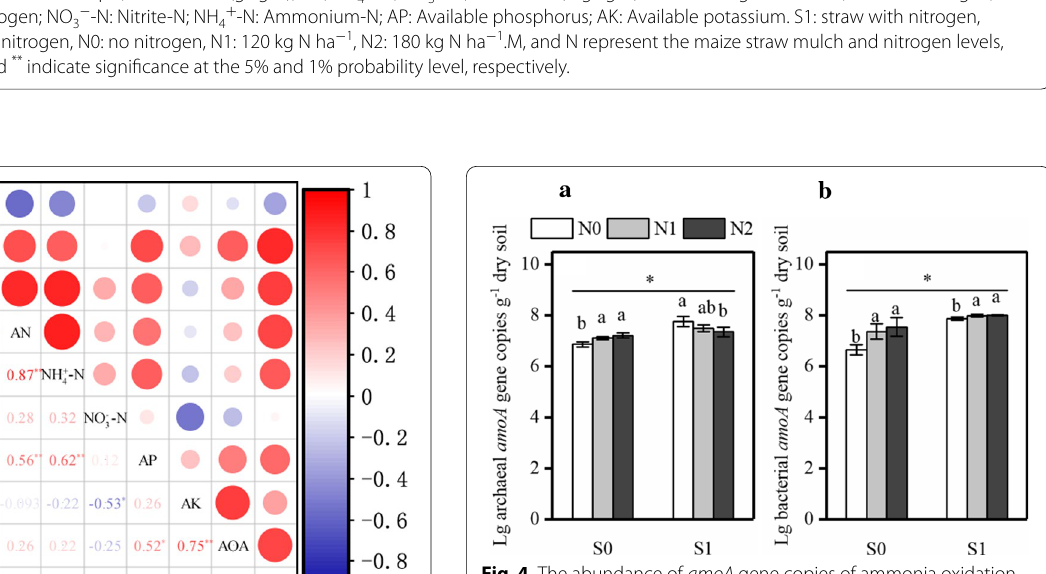
Fig. 4 The abundance of amoA gene copies of ammonia oxidation archaea ( a ) and bacteria ( b ) in the different treatments. Data were mean S.D. S1: Straw with nitrogen, S0: no straw with nitrogen, N0: ± No nitrogen, N1: 120 kg N ha − 1 , N2: 180 kg N ha − 1 . * , and different letters indicate significate at the 5% probability level,